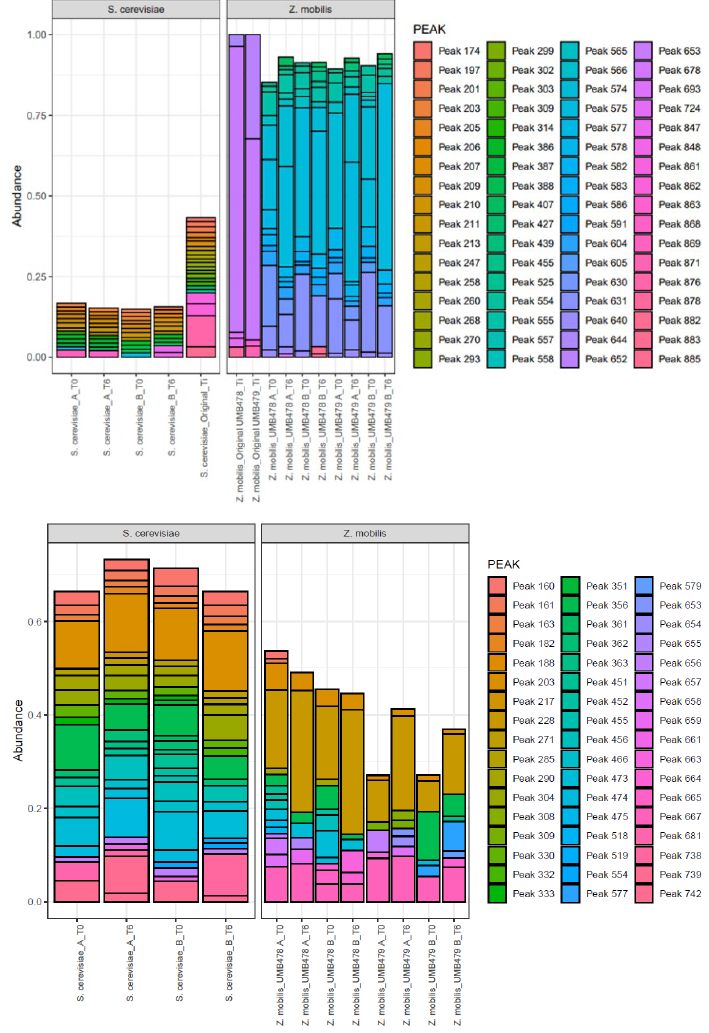
Figure A1. Population dynamics showing composition of ITS peaks (>1%) ( top ) and of 16S peaks (>1%) ( bottom ). Average values of three replicates are shown for each bar.